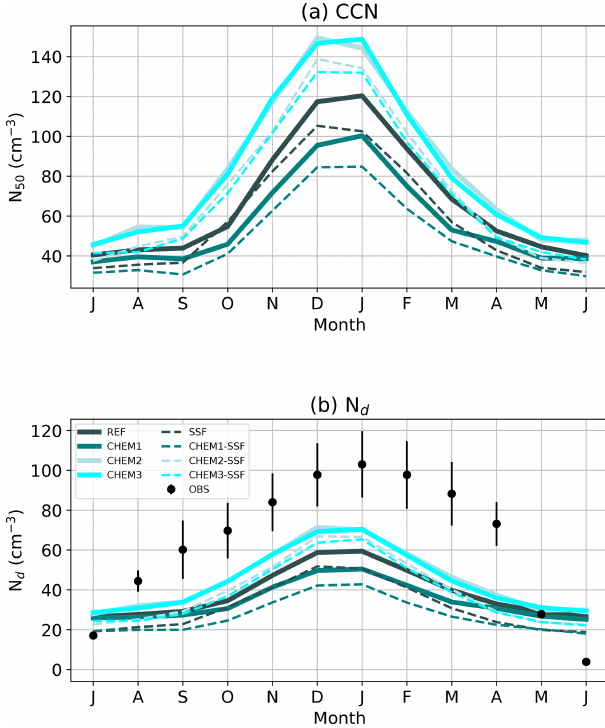
Figure 10. (a) Climatological-mean seasonal cycle in the concen- tration of cloud condensation nuclei at 800m above the surface be- tween 40 and 60 ◦ S. (b) As for panel (a) but showing the cloud droplet number concentration at the cloud top. The N d observations shown are derived from MODIS data over the period 2003–2015 (Grosvenor et al., 2018). The climatological monthly mean is plot- ted for all years available of observational data and model data. The error bars on the observations indicate the standard deviation on the climatological monthly